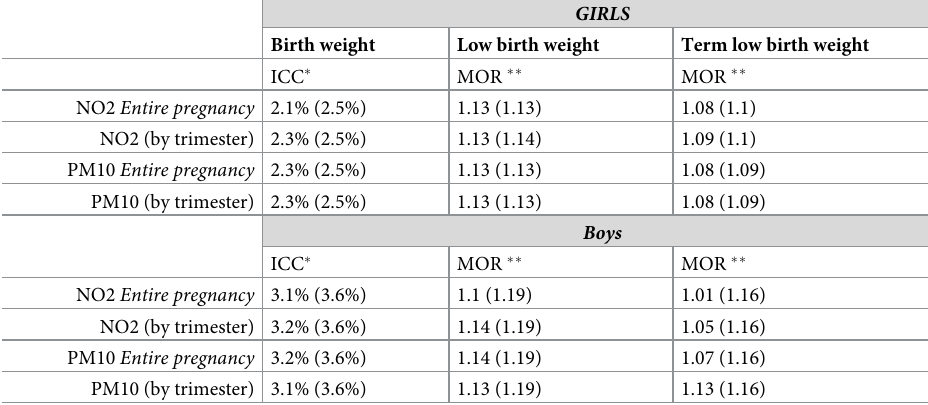
Table 5. Measure of census blocks